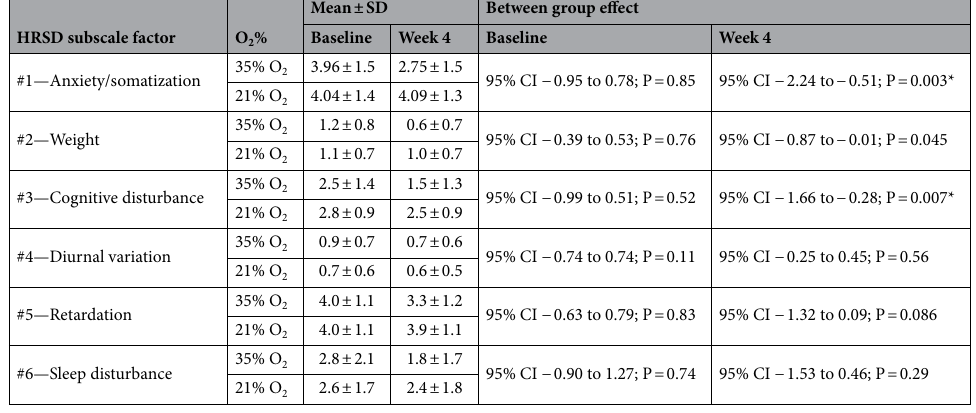
Table 3. Effect of oxygen treatment on HRSD sub-scale factors improvement. CI confidence interval, HRSD Hamilton rating scale for depression, SD standard deviation. *P < 0.008 (significant).